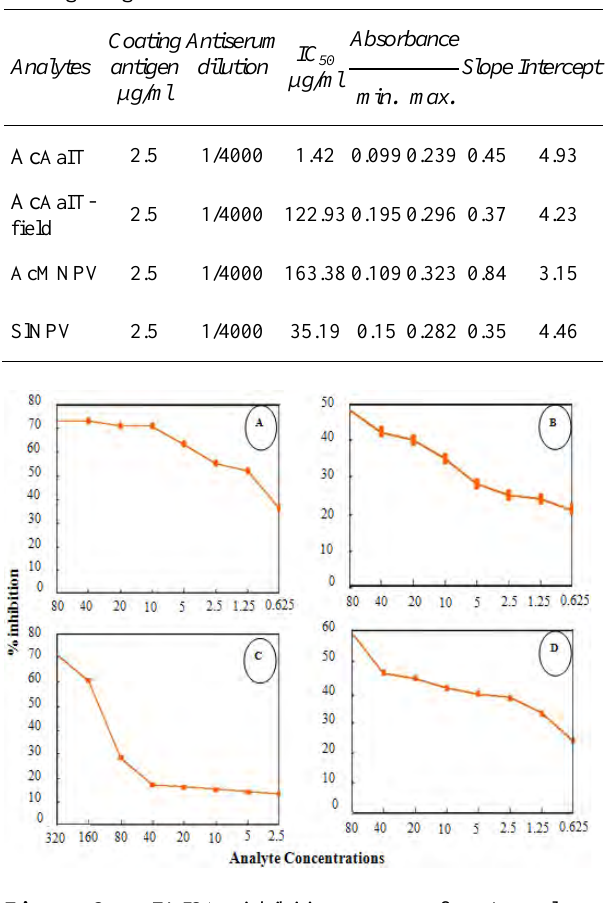
*Cross-reactivity was calculated as (IC analyte) x 100. AcAaIT polyhedrin was used as the coating antigen.